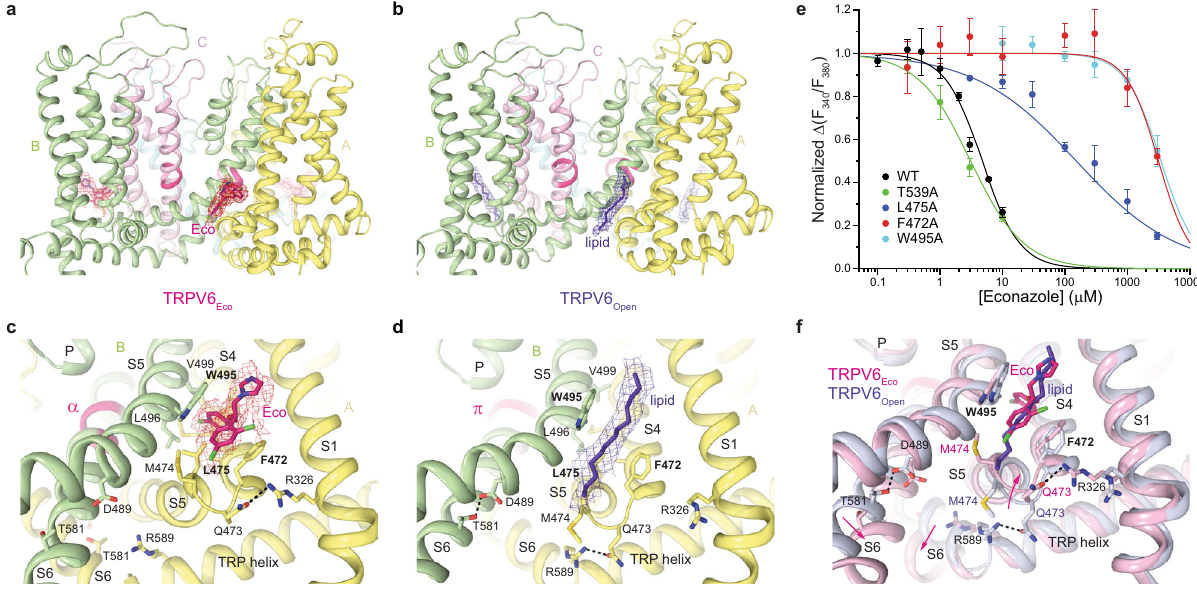
Fig. 4 Allosteric binding site of econazole. a , b TMD in TRPV6 Eco ( a ) and TRPV6 Open ( b ) viewed parallel to the membrane. c , d Close-up view of the econazole-binding site in TRPV6 Eco ( c ) and TRPV6 Open ( d ). The molecule of econazole, residues contributing to its binding, and the lipid occupying the peripheral site in the open-state structure are shown as sticks. Dashed lines represent hydrogen bonds or salt bridges between residues. e Dose – response curves for econazole inhibition of Ca 2 + uptake calculated for wild-type (WT) and mutant TRPV6 channels. The changes in the fl uorescence intensity ratio at 340 and 380 nm ( F 340 / F 380 ) evoked by the addition of 5 mM Ca 2 + after pre-incubation with various concentrations of econazole were normalized to the maximal change in F 340 / F 380 after addition of 5 mM Ca 2 + in the absence of econazole. Straight lines through the data points are fi ts with the logistic equation, with the mean ± SEM values of the half-maximum inhibitory concentration ( IC 50 ), 4.39 ± 0.31 µ M for WT ( n = 9), 3.09 ± 0.22 µ M for T539A ( n = 3), 151 ± 20 µ M for L475A ( n = 3), 3.14 ± 0.24 mM for F472A ( n = 6) and 3.43 ± 0.52 mM for W495A ( n = 6). Source data are provided as a Source Data fi le. f Superposition of the econazole-binding site region in TRPV6 Eco (pink) and TRPV6 Open (purple). Pink arrows illustrate the movement of the S4 – S5 linker and S6 upon econazole binding.